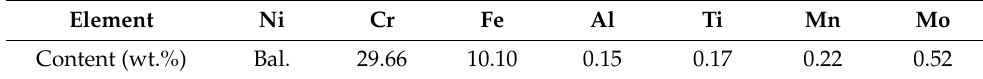
Table 1. Chemical compositions of Inconel 690 powders (wt.%). Element